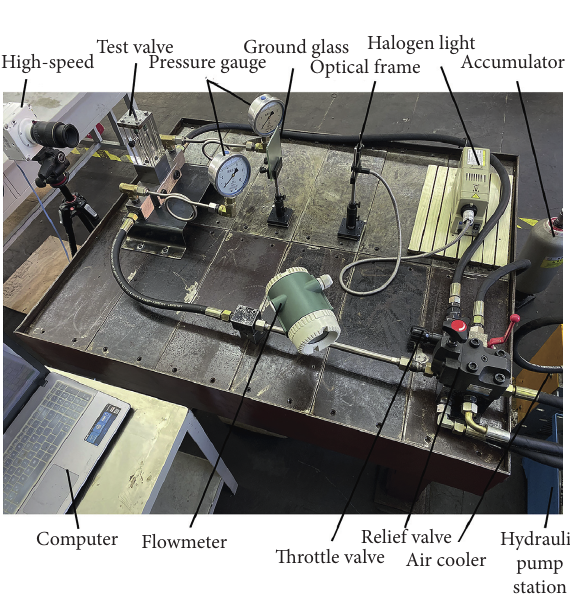
Figure 2: Illustration of experimental hydraulic